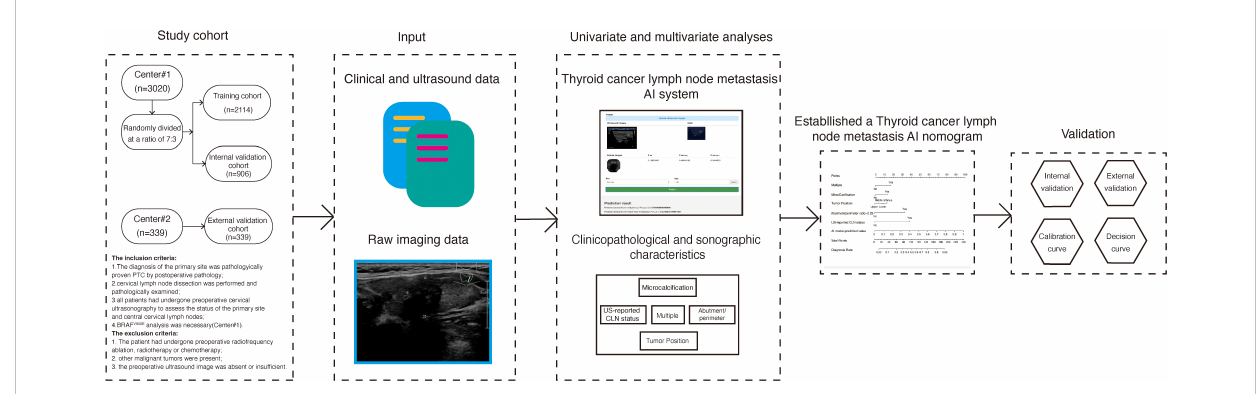
FIGURE 1 Flow diagram of the thyroid cancer lymph node metastasis